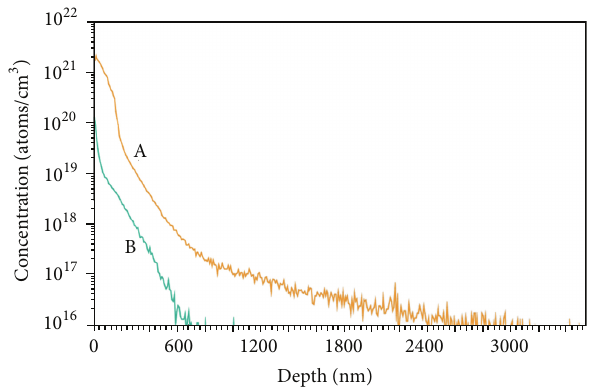
Figure 3: Concentration-depth relation of the phosphorus doping, measured by SIMS, for shallow trench area (curve A) and region between contacts (curve B).